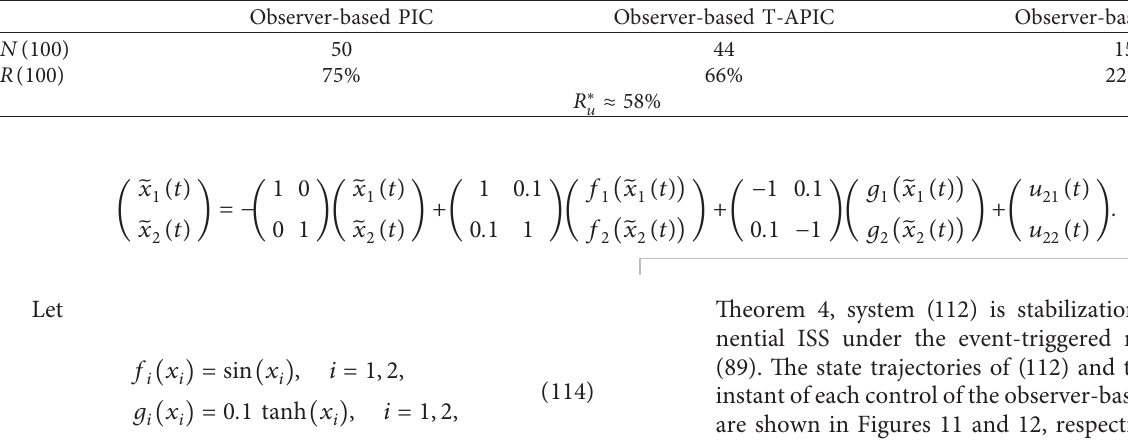
Table 1: Contrasts among observer-based PIC, observer-based T-APIC, observer-based